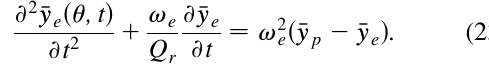
FIG. 16. (Color) Threshold voltage versus bunch charge for (cid:5) 177 ns , Q (cid:5) 2 : 5 , and electron line densities PSR with (cid:6) b r of 0 : 1 , 0 : 5 , and 1 : 0 nC = m . This estimate used the coasting beam dispersion relation, Eq. (18), and a parabolic momentum distribution with the same rms width as for Fig. 15. The threshold curve for historical PSR data is shown for compar- ison. For the data, the momentum spread from the LINAC is present even with zero rf